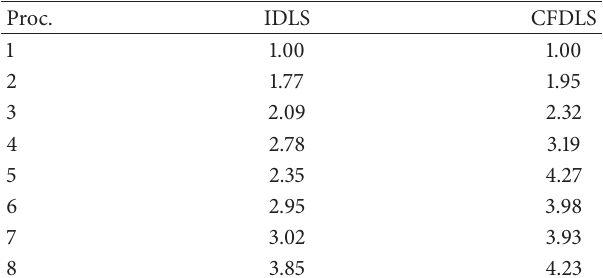
Table 5: Speed-up: 𝑁 (𝐵) with random start. Proc.